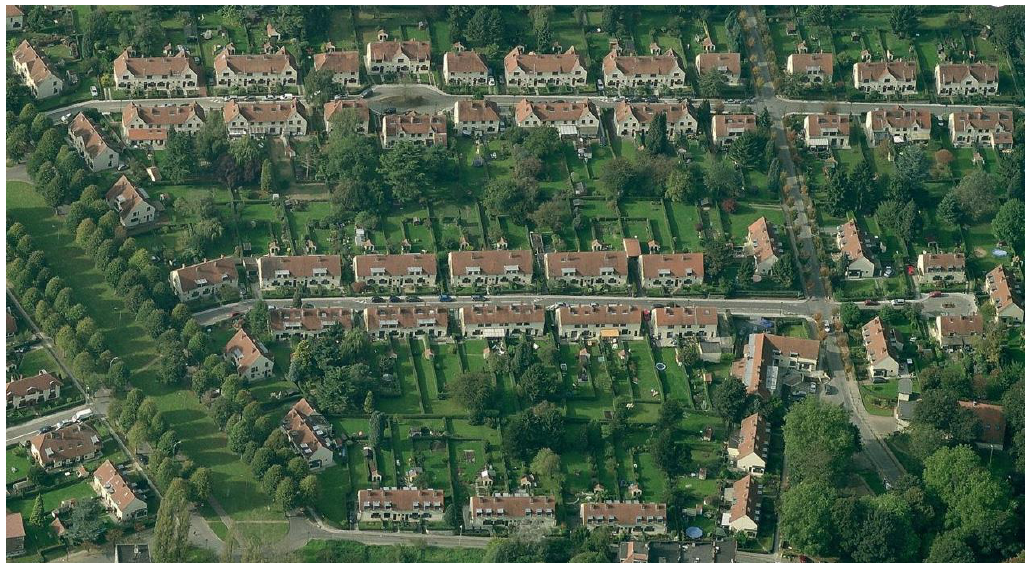
Figure 2. Moortebeek (2014). Source data: Bing Maps (2014).